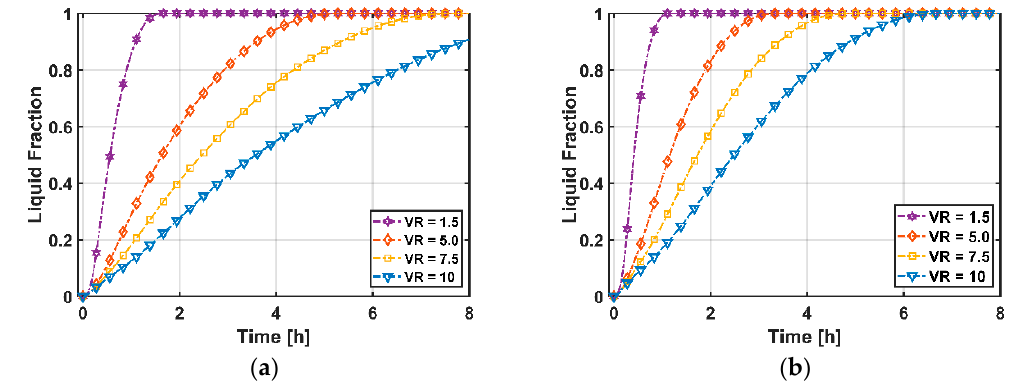
Figure 13. LiquidFractionsforvaryingvolumeratio( a )418–460K,( b )403–473K( PCM Temperature— HTF Figure 13. Liquid Fractions for varying volume ratio ( a ) 418–460 K, ( b ) 403–473 K ( PCM Inlet Temperature). Temperature— HTF Inlet Temperature).